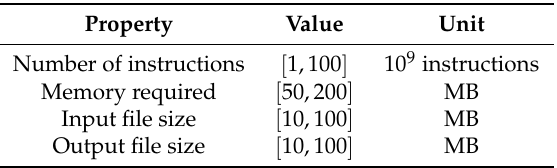
Table 4. Attributes of